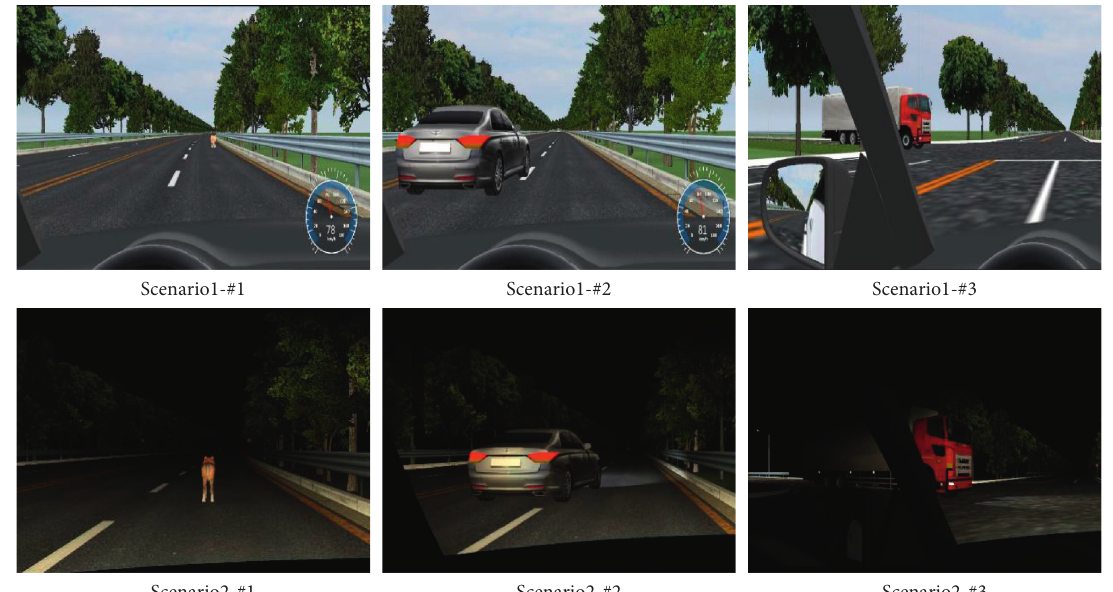
Figure 2: Images of experimental